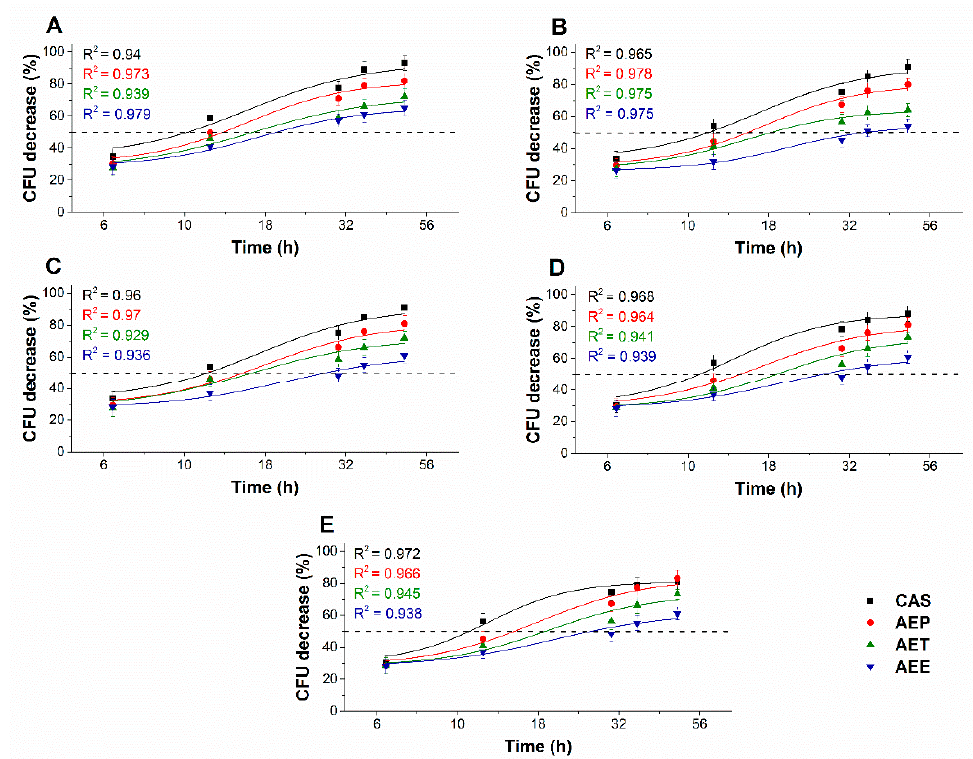
Figure 10. E ff ects of AEP, AET, and AEE at their MEC 10 concentrations on the metabolic activities of the mean percentage colony-forming unit (CFU / mL) decrement of the planktonic S. pombe ( A ), C. albicans ( B ), C. tropicalis ( C ), C. dubliniensis ( D ) and C. krusei ( E ) compared to their respective 0 h samples and caspofungin (CAS) standard antimicrobial controls after 6, 12, 30, 36 and 48 h of treatment (mean ± SD, n = 6 independent experiments each with three technical replicates).